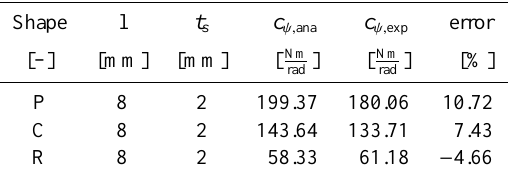
Table 3. Bending sti ff ness c ψ for rectangular (R), circular (C) and parabolic (P) flexure hinges: analytical calculations and experimen- tal results.